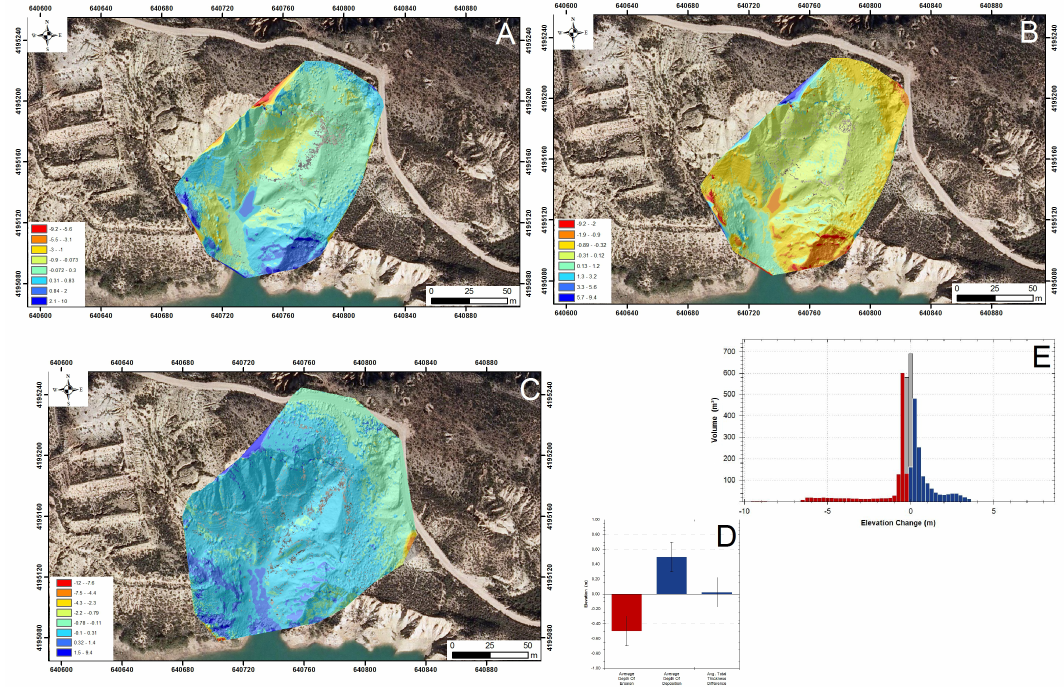
Figure 12. Bank gully (B.G-3)( A ) DoD Mission I and II. ( B ) DoD Mission II and III. ( C ) DoD Mission I and III. ( D ) Graphe of DoD volume. ( E ) Bar chart of DoD volume change distribution (erosion volume in red, deposition volume in